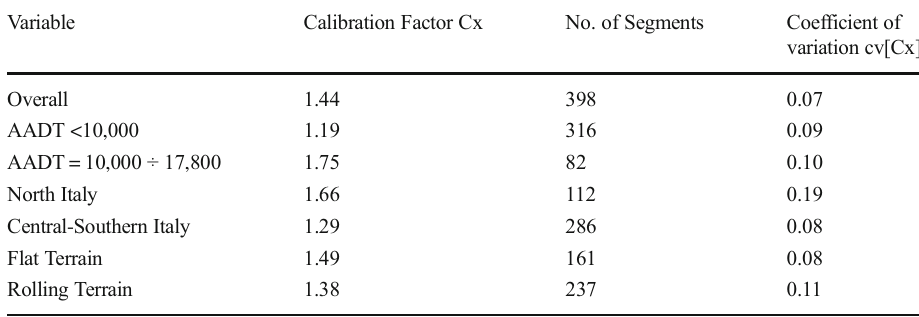
Table 2 Example of Calibration Factors (Italian two-lane rural road segments